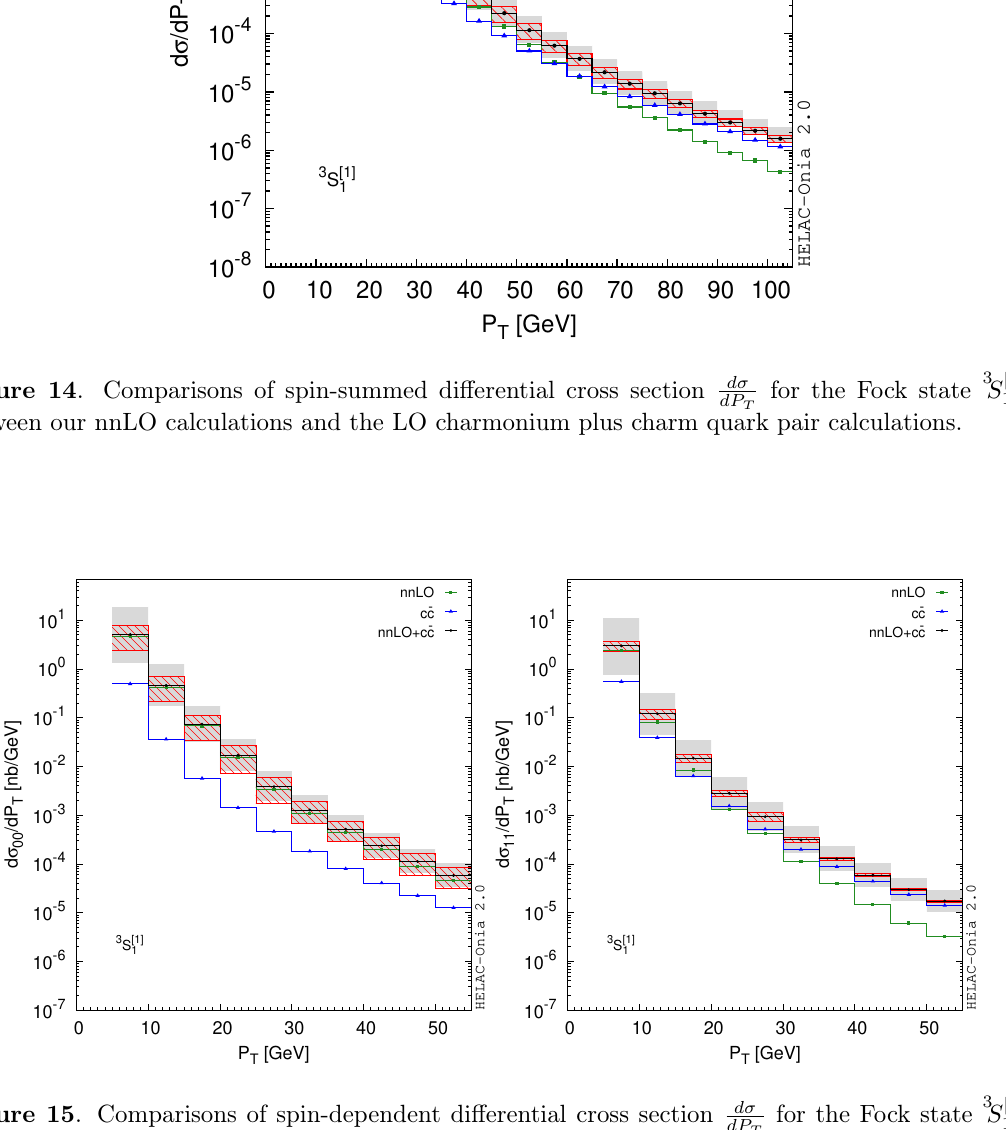
for the Fock state 3 S [1] 1 dP T